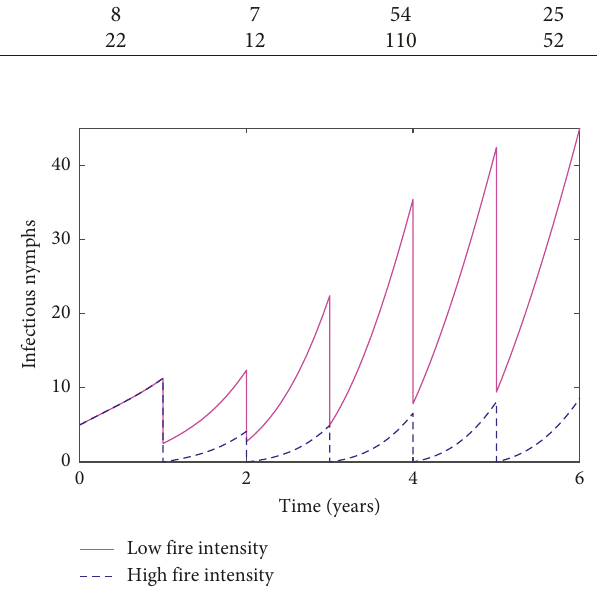
Figure 3: Simulation of annual burns for six years at varying intensities. Parameter values are given in Table 1.